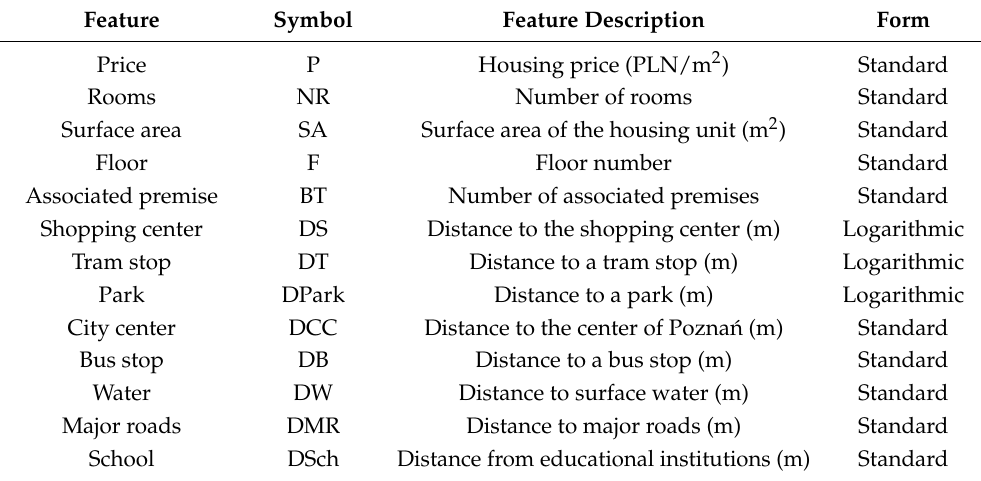
Table 3. Characteristics of qualitative and quantitative variables applied in the model. Feature Symbol